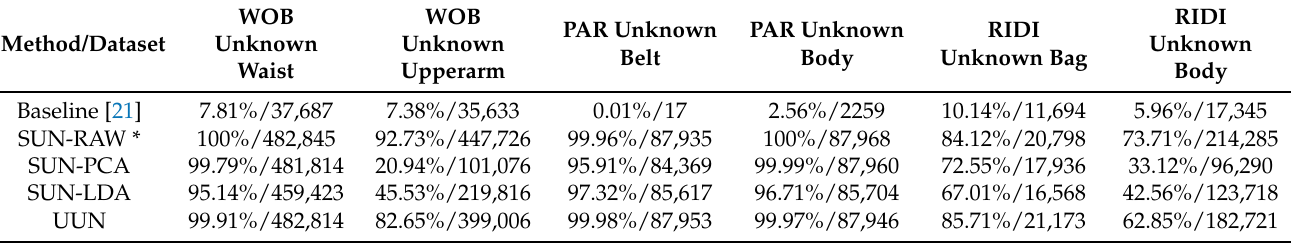
Table 6. Accuracy/Number of corrected samples results on different testing datasets used our SUN and UUN approaches.